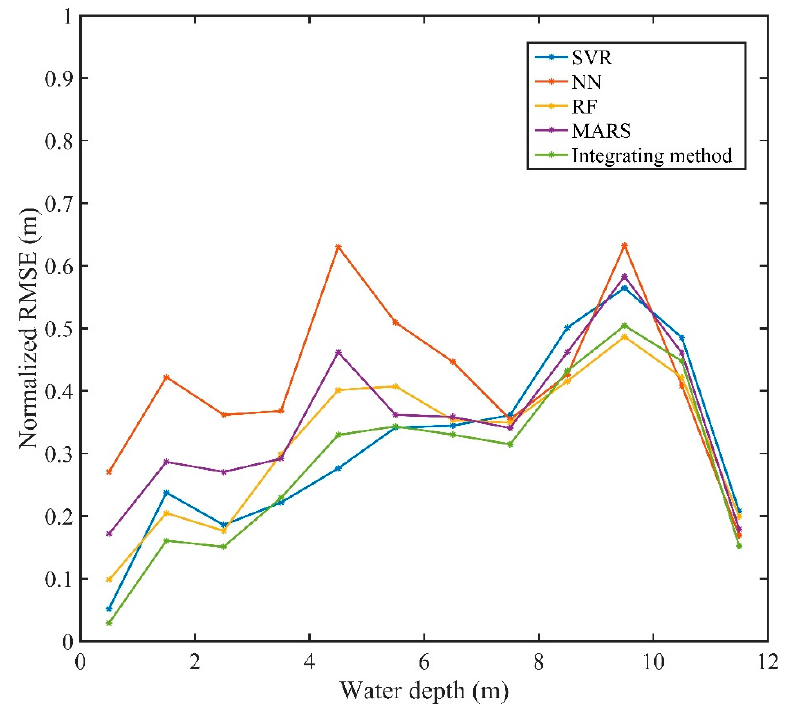
Figure 6. The normalized RMSE with different water depth ranged of different methods.